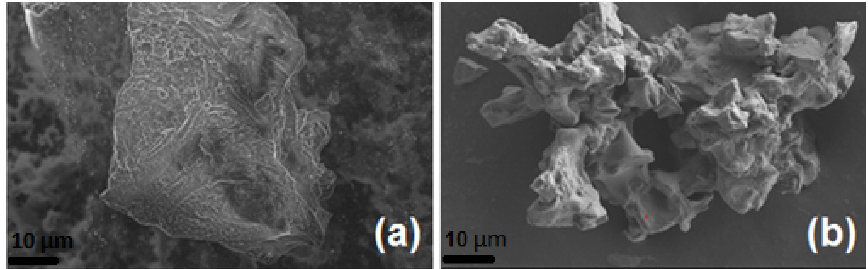
Figure 4. SEM micrographs of unmodified coffee biowaste (Coffee) ( a ) and coffee biowaste modified with phosphorus (P-coffee) ( b ). Table 2. Chemical composition of unmodified coffee biowaste (Coffee) and coffee biowaste modified with phosphorus (P-coffee) obtained in EDX (the mean of the obtained values at three different points). The elemental analysis proves the presence of phosphorus in P-coffee. The percentage of phosphorus was estimated to be 20 wt.% for P-coffee. Moreover, carbon and oxygen are increased after modification of Coffee.